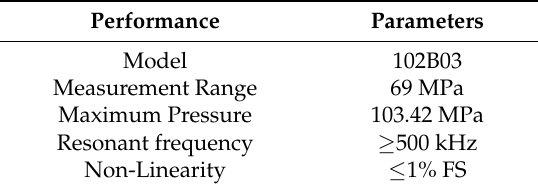
Figure 1. Schematic of the experimental setup. Table 1. Main specifications of the pressure transducer.